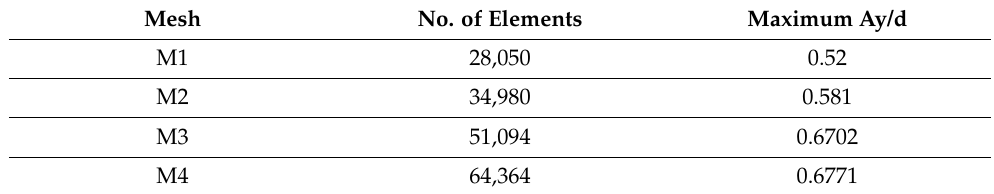
Table 1. Grid independency tests with RANS kw-sst Model.